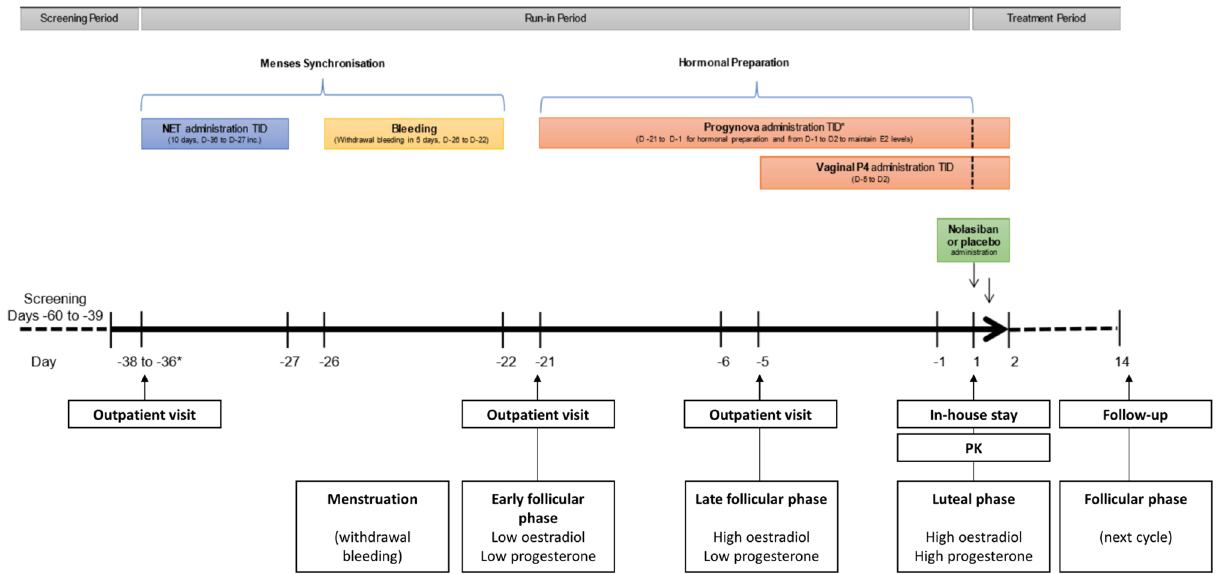
Figure 2. Diagram of synchronised run-in period. Each study day except for Day 1 includes an outpatient visit where a meal was served prior to ECG screening. NET—norethisterone, PK—pharmacokinetics, TID—three